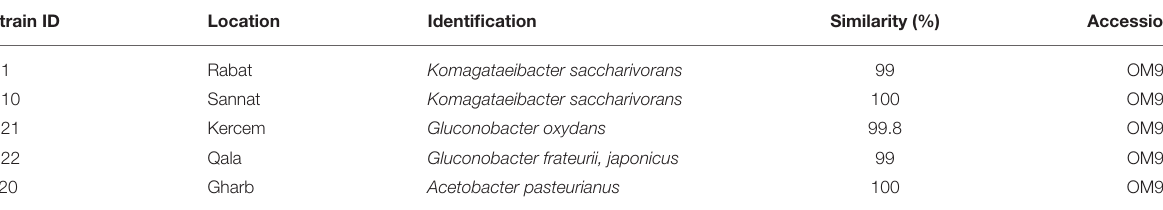
TABLE 2 | Best-match identification phylotypes of purified PCR products deriving from the 16S rRNA amplification of the isolated strains. Strain ID